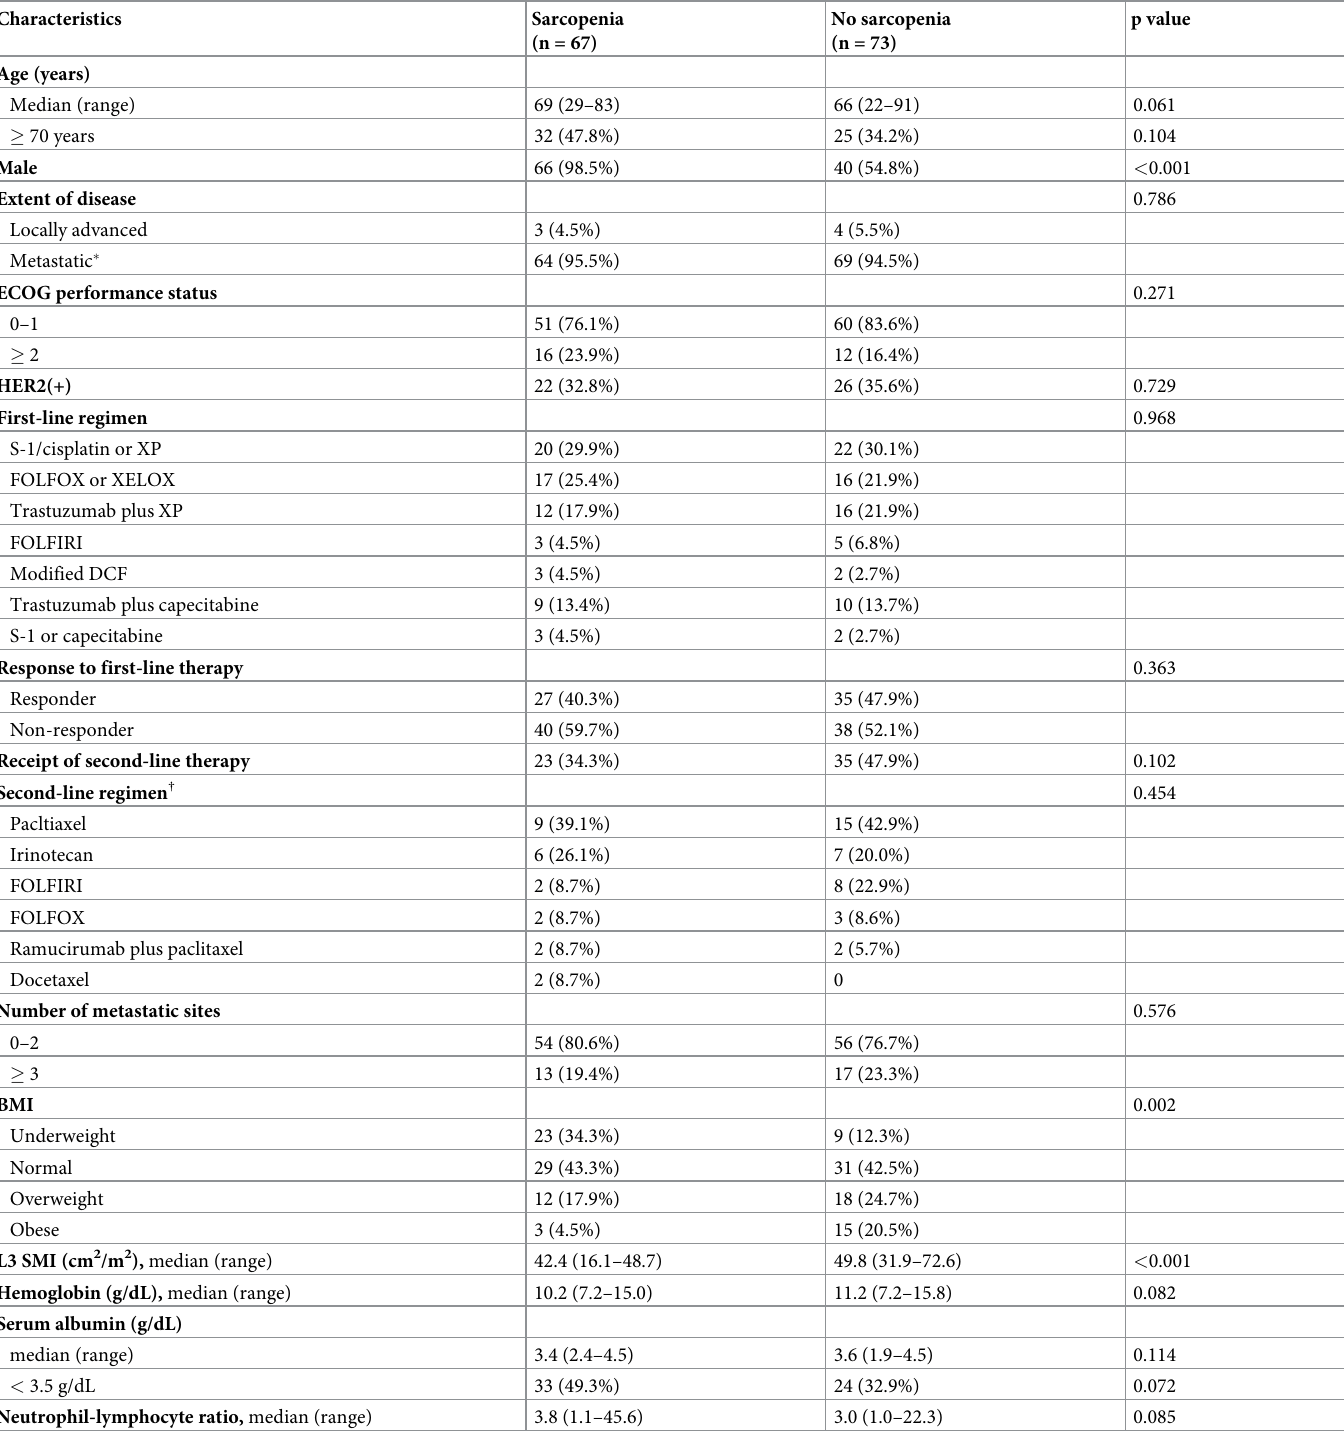
Table 1. Patient characteristics according to the presence of